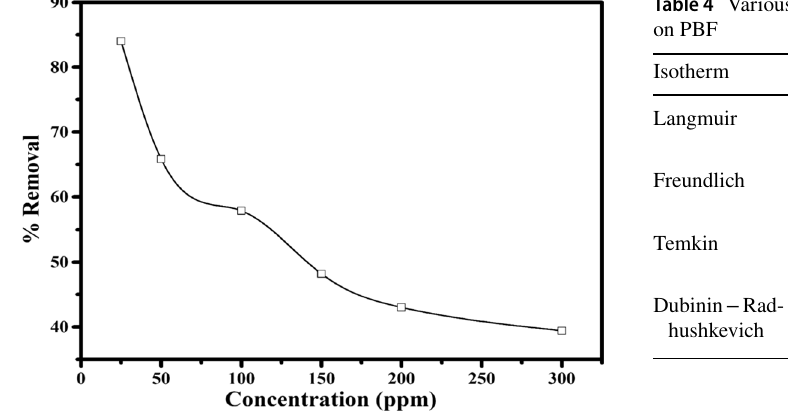
Fig. 5 Impact of initial MB dye concentration on PBF adsorbent at optimum conditions (pH 6, PBF dose 1 g, contact time 12 h)